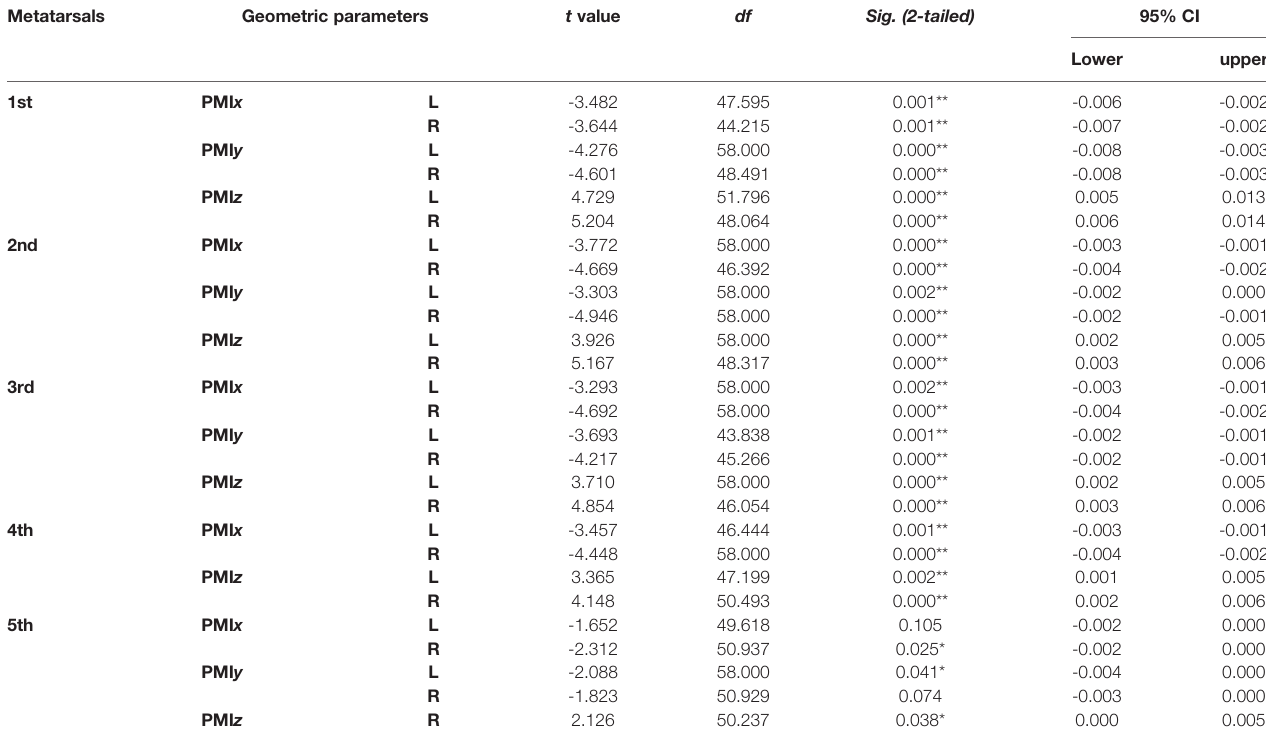
TABLE 6 | Independent sample t -test results of normalized PMIs of metatarsal bone in vivo based on its PAI between sexes. Metatarsals Geometric parameters